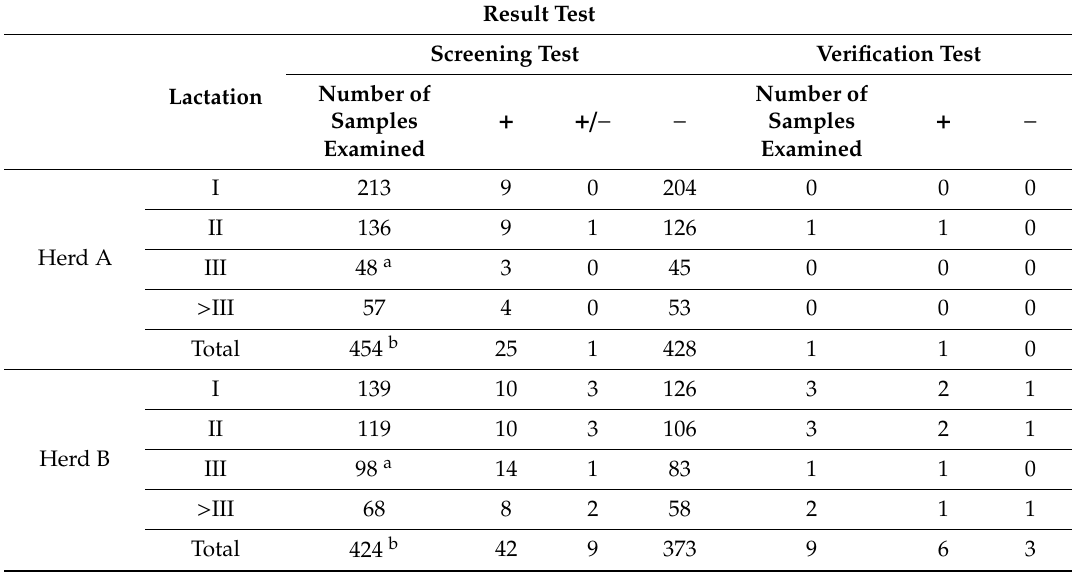
Table 1. The paratuberculosis seroprevalence in dairy cattle herds divided into groups of